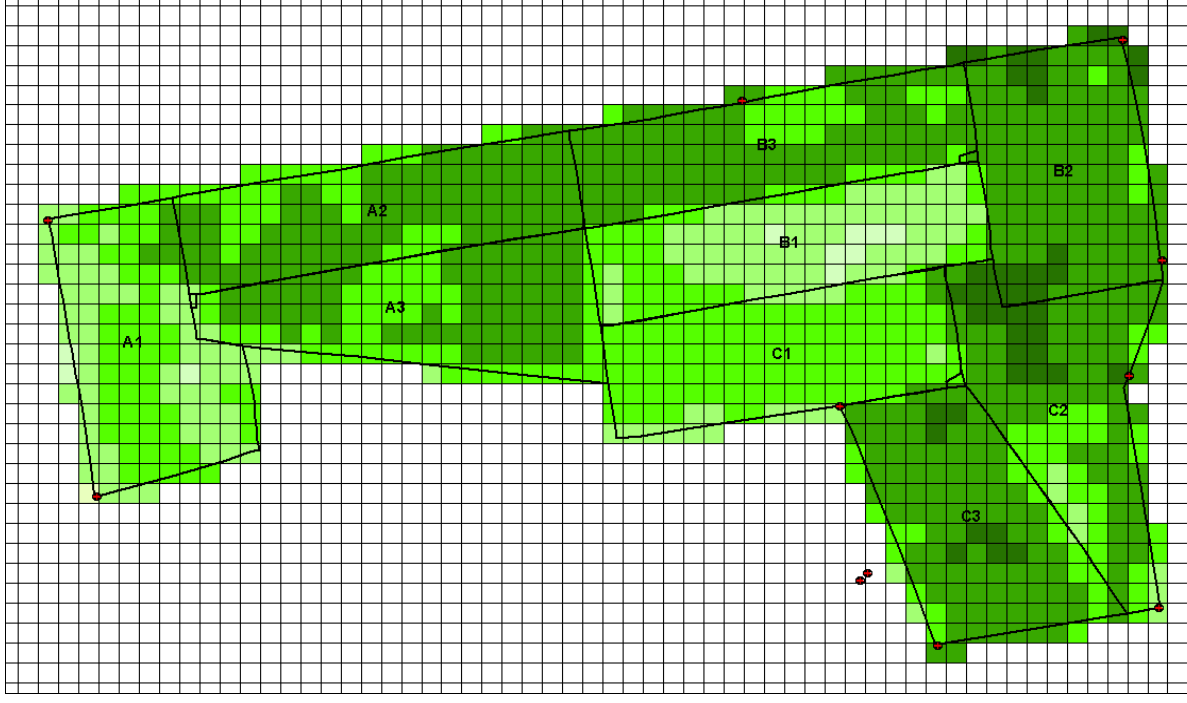
Figure 6 . NDVI analysis of the Planet image for the 10 m polygon grid (02 June